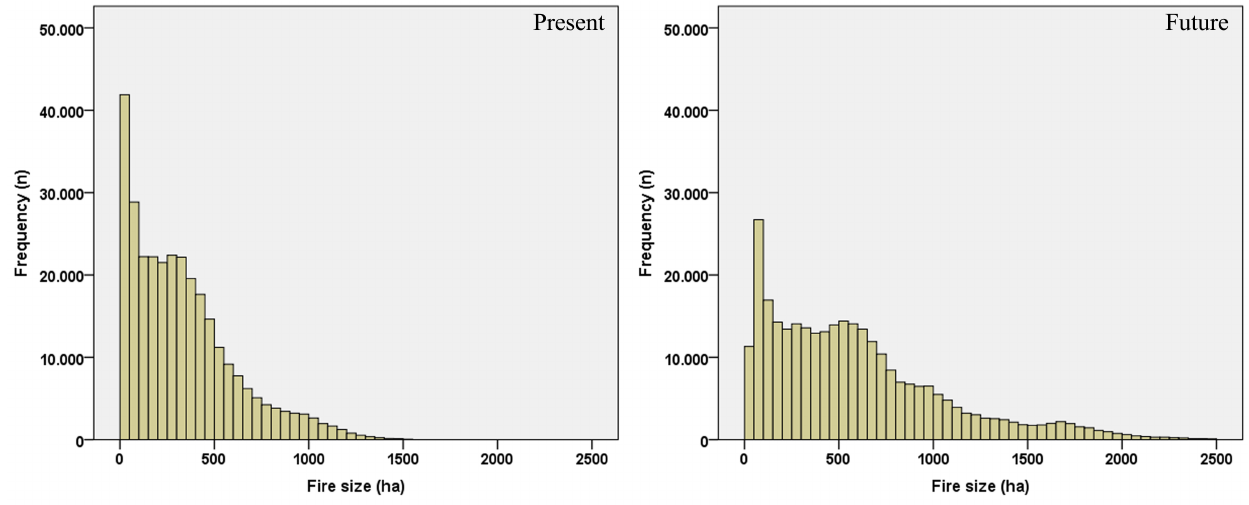
Figure 6. Histograms of fire size vs. frequency of present and future time